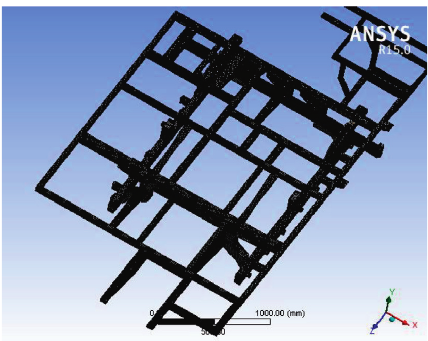
Figure 9: Meshing model of crawler chassis.